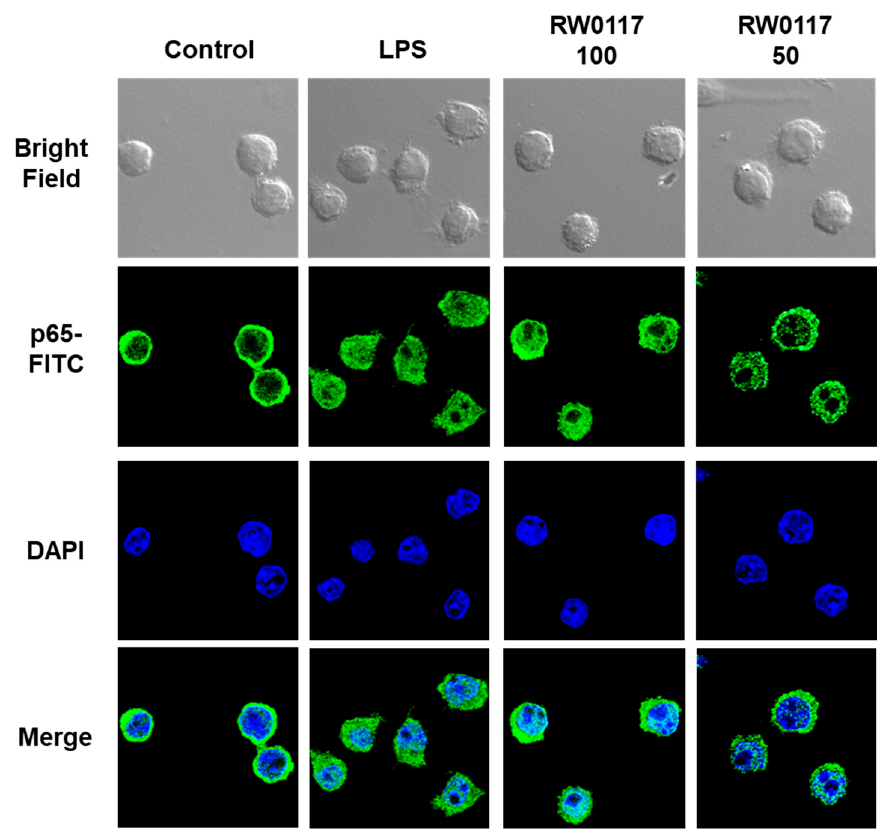
Figure 6. RW0117 inhibits LPS-induced p65 nuclear translocation in RAW264.7 cells. RAW264.7 cells were seeded onto 0.1% gelatin-coated coverslips for overnight. After that beeswax alcohol (100 μ g/mL) or RW0117 (100 μ g/mL, 50 μ g/mL) treated for 2 h, then stimulated with LPS (1 μ g/mL) for 1 h. RAW264.7 cells were fixed and immunostained with anti-p65-FITC antibody and the nucleus was counterstained with DAPI. The fluorescence images were acquired using ZEN 2.3 confocal imaging software. LPS was used as a positive control for activation of RAW264.7 cells.